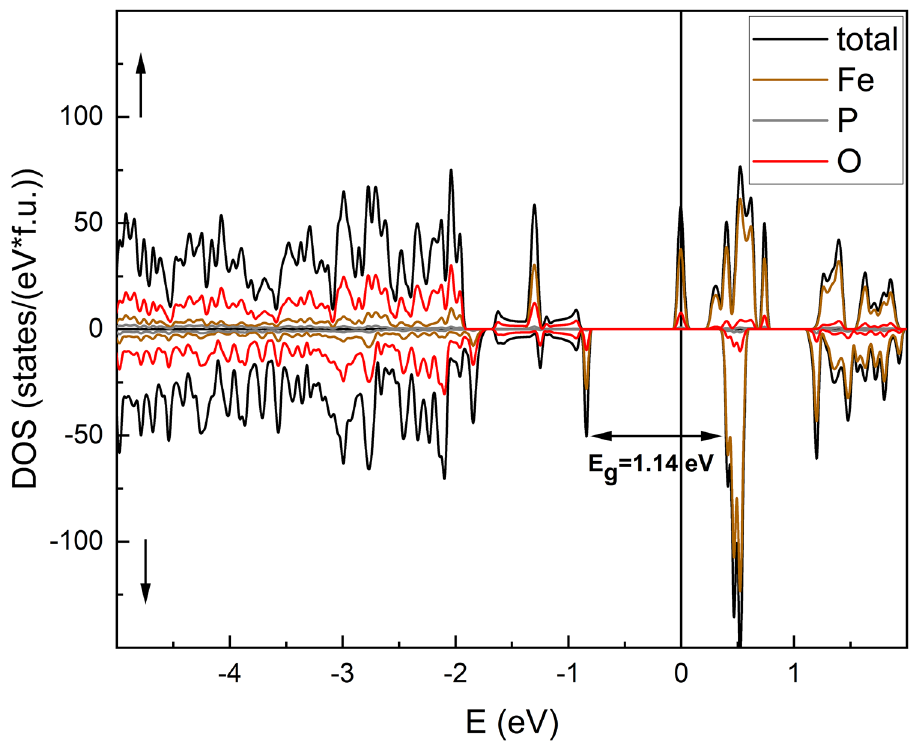
Figure 5. The total density of electronic states (DOS) of Fe 7 P 11 O 38